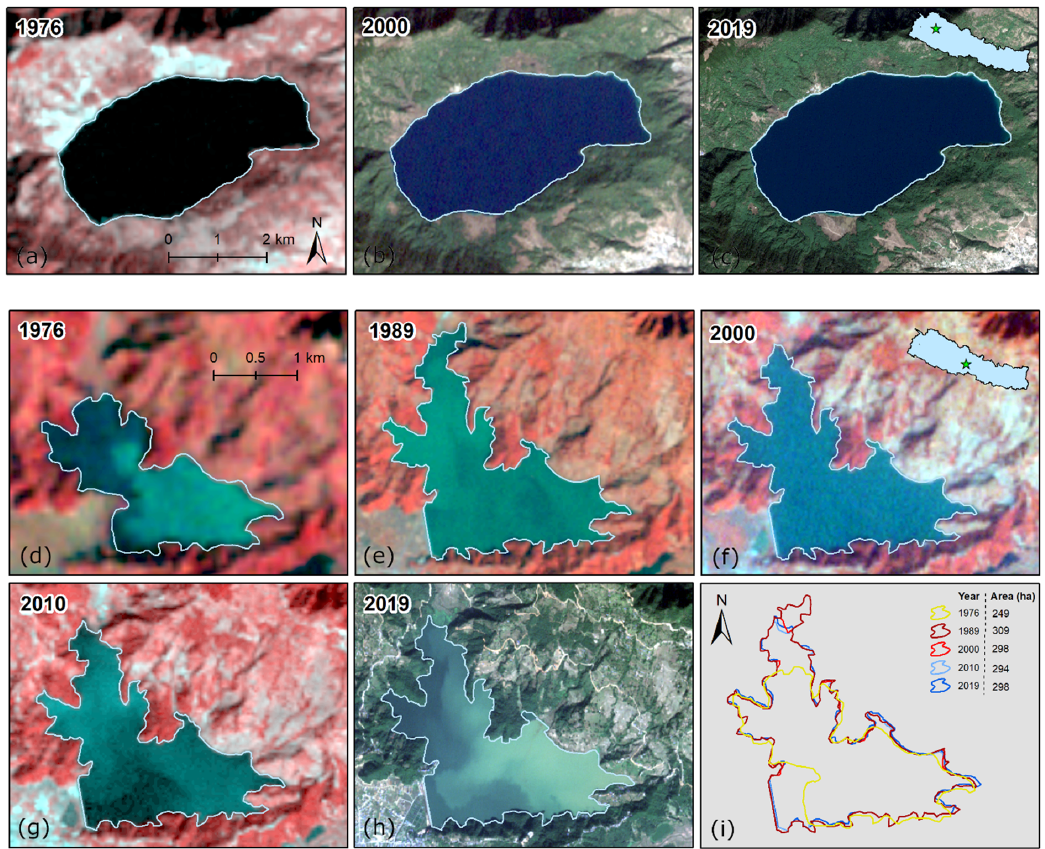
Figure 6. Evolution of Rara ( a – c ) and Begnas Lakes ( d – i ) between 1976 and 2019.